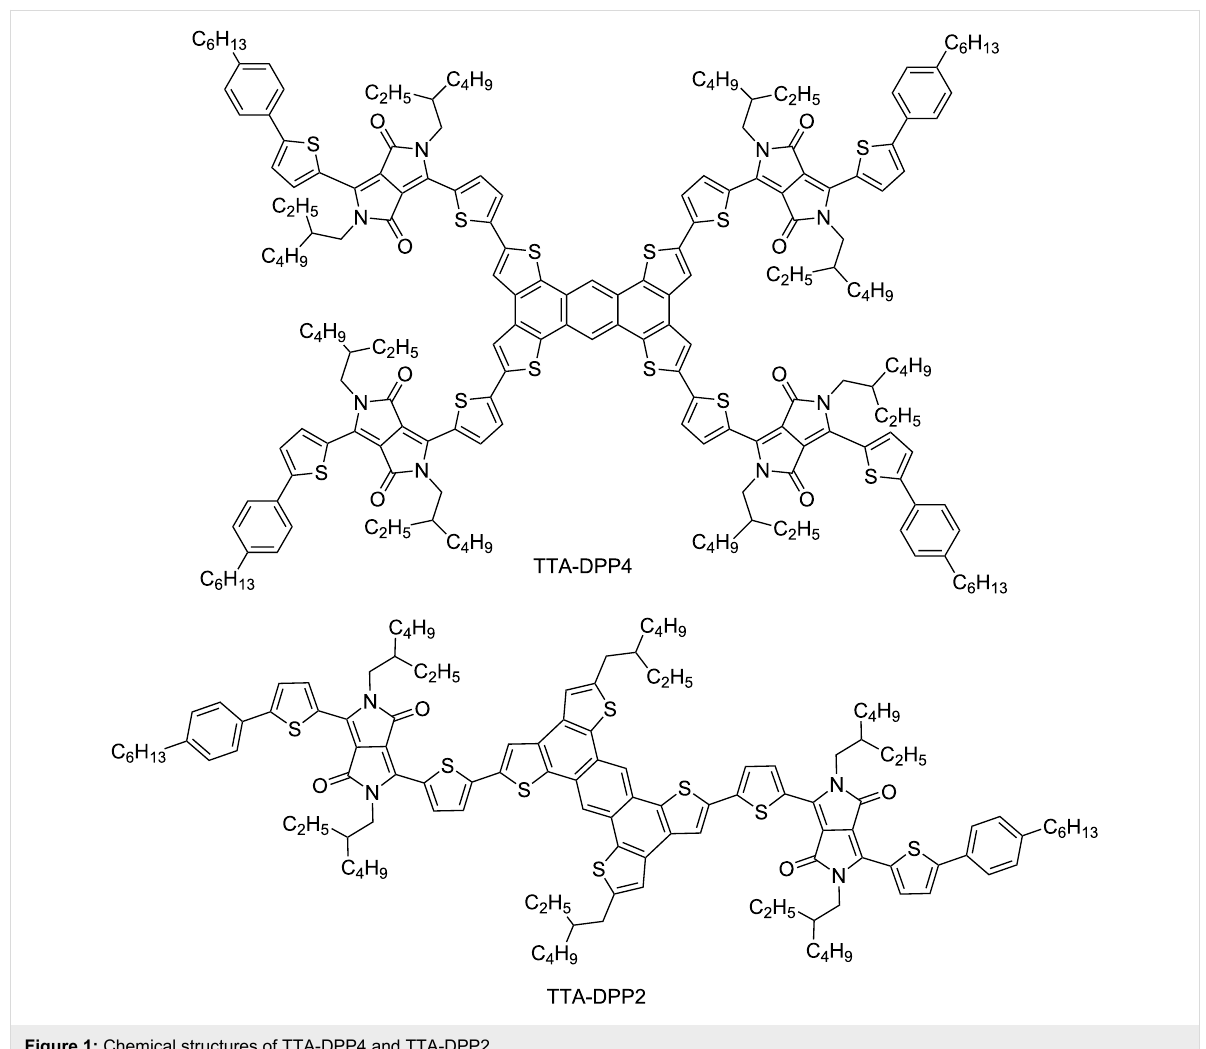
Figure 1: Chemical structures of TTA-DPP4 and